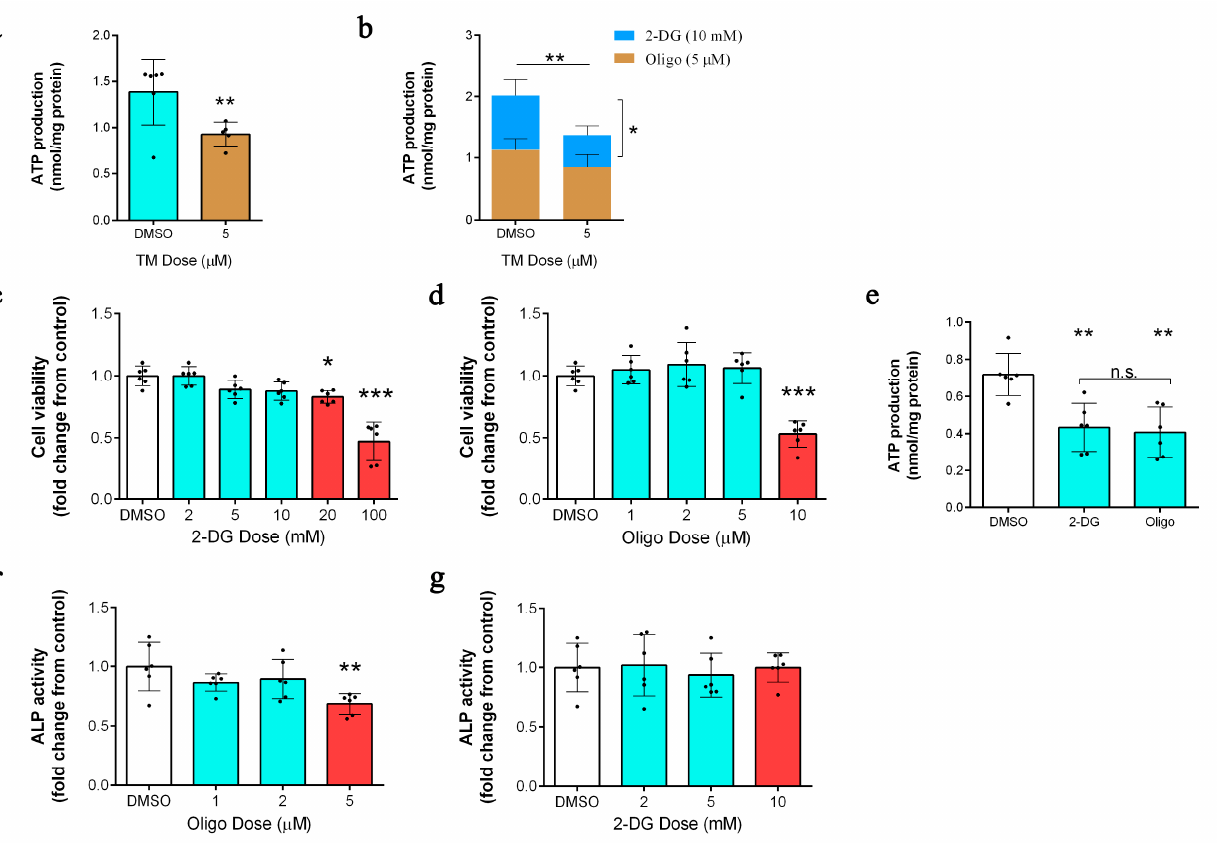
Figure 4. ( a ) ATP production after 72 h of treatment with TM (5 µM) ( n = 6/group); ** p < 0.01. ( b ) After TM treatment for 48 h, measured ATP production after 24 h of treatments with 2-DG (10 mmol) and oligo (5 µM) ( n = 6/group); * p < 0.05, ** p < 0.01. ( c , d ) A cell counting kit-8 (CCK-8) assay was used to assess the effect of 2-DG and oligo concentrations on DPC viability after 24 h of treatment ( n = 6/group); * p < 0.05, *** p < 0.001. ( e ) ATP production after 24 h of treatments with 2-DG (10 mmol) and oligo (5 µM) ( n = 6/group); ** p < 0.01. ( f , g ) Measurement of ALP activity in DPCs after 24 h of treatments with 2-DG and oligo ( n = 6/group); ** p < 0.01.